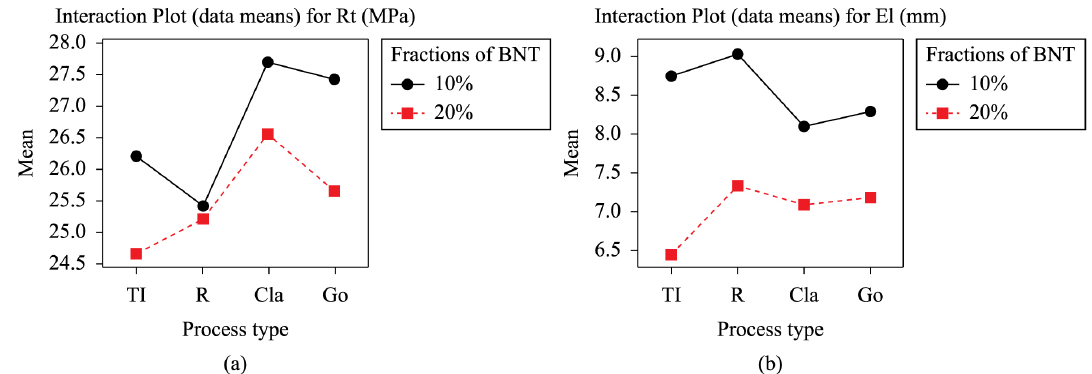
Figure 1. Interactions between the major influences (BNT) on (a) tensile strength and (b) maximum tensile strain through